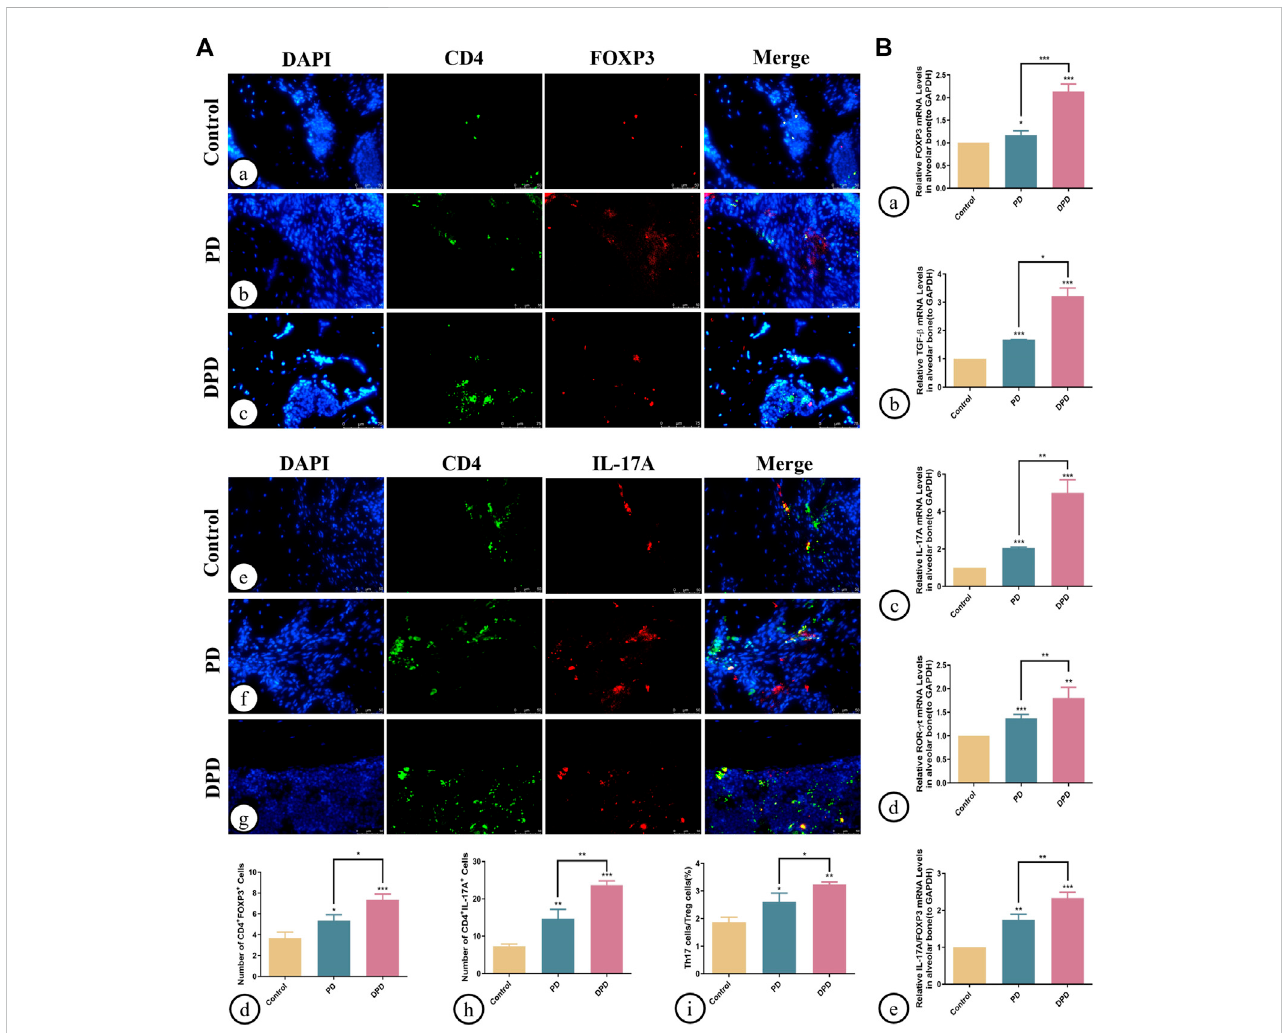
FIGURE 3 Immuno fl uorescence and qRT-PCR analysis of Th17 and Treg cells in the maxillary alveolar bone. (A) The representative immuno fl uorescence staining images of CD4 + FOXP3 + T cells in the (a) control, (b) PD and (c) DPD groups. (d) The statistical analysis of CD4 + FOXP3 + T cell counts. The representative immuno fl uorescence staining images of CD4 + IL-17A + T cells in the (e) control, (f) PD and (g) DPD groups. (h) The statistical analysis of CD4 + IL-17A + T cell counts. (i) The ratio of Th17/Treg cells. (B) Relative mRNA expression level of (a) FOXP3, (b) TGF- β , (c) IL-17A, (d) ROR- ɣ t, and (e) the ratio of IL-17A/ FOXP3 in the control, PD and DPD groups. Data were shown as mean ± SD (* p < 0.05. ** p < 0.01. *** p <